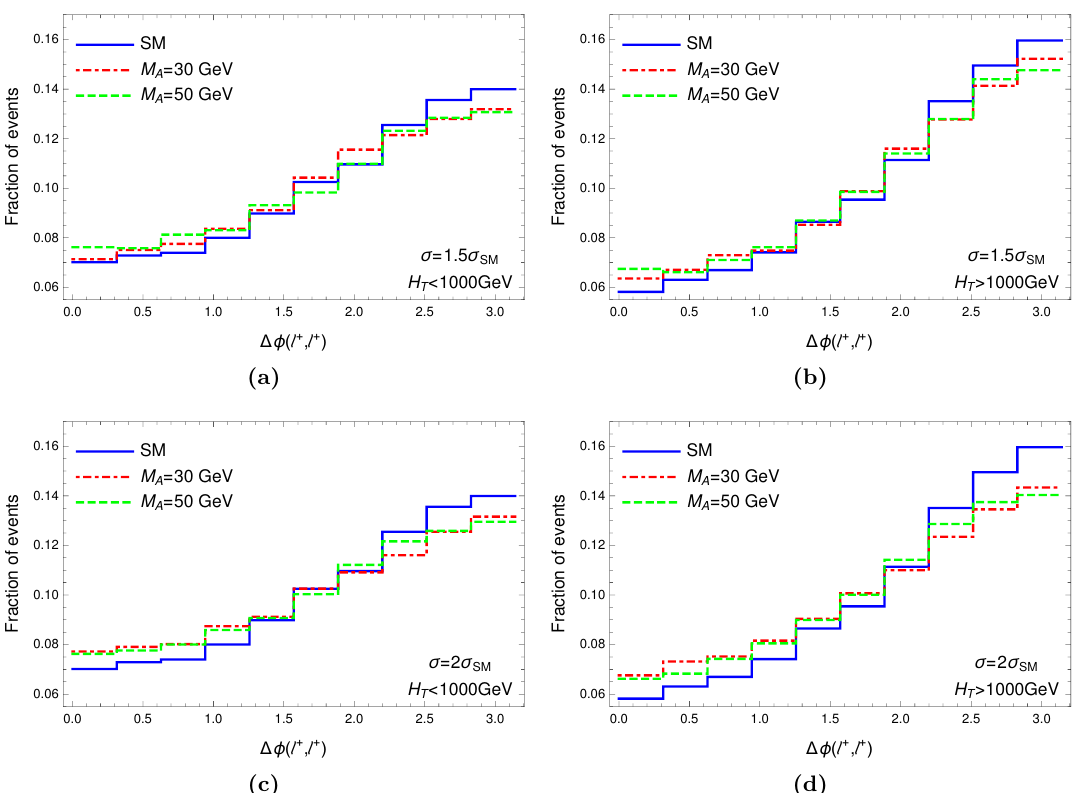
Figure 12. Distribution of the azimuthal separation between the same-sign leptons, (cid:1) (cid:30) ( ‘ + ; ‘ + ), for the 2LSS channel after preselection (see text for details) with (left) H T < 1000 GeV and (right) H T > 1000 GeV, normalized to unit area. Shown are the predictions for the SM (blue) and the Pseudo-scalar model for (a, b) the tight benchmark points (i.e. giving (cid:27) = 1 : 5 (cid:27) SM ) and (c, d) the loose benchmark points (i.e. giving (cid:27) = 2 (cid:27) SM ).